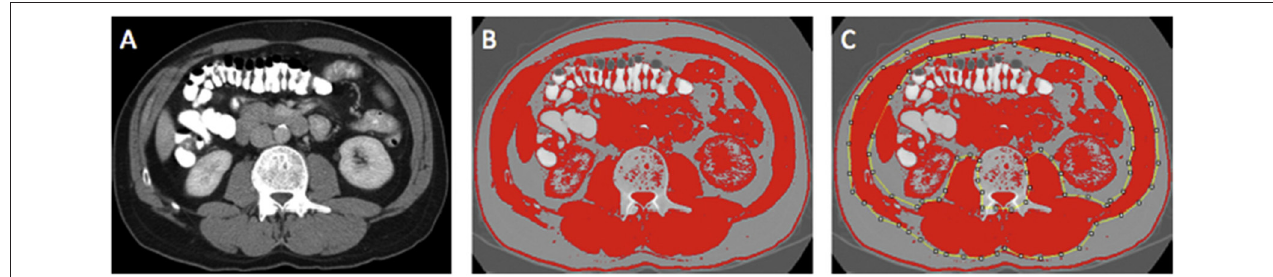
FIGURE 3 | Example of selection of CT body composition—skeletal muscle area (SMA) using ImageJ software; (A) mid-L3 vertebra axial slice from preoperative portal venous phase CT; (B) threshold selection of skeletal muscle tissue using automatic selection of pixels of radiodensity ranging _29–150 Hounsfield units (HU); (C) region of interest (ROI) selection for SMA (cm 2 ). Adapted from McSorley et al. (22).